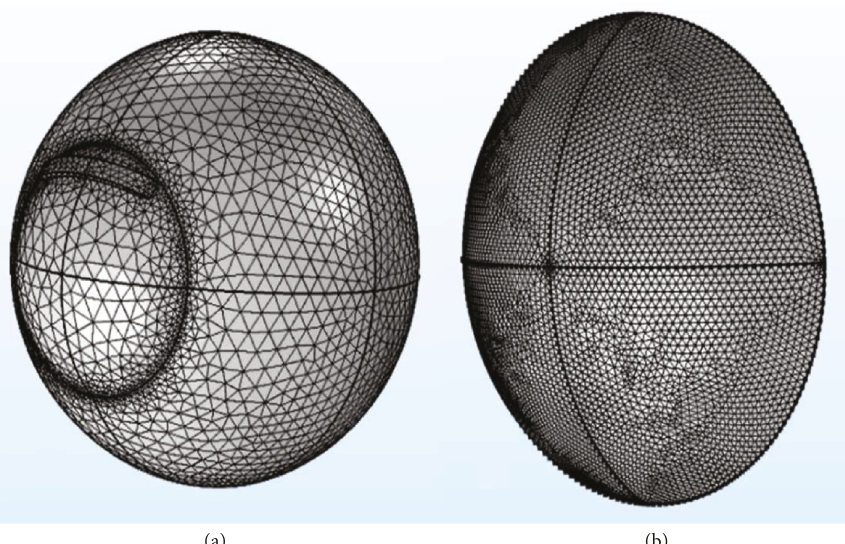
Figure 4: Meshing of the eye (a) and contact lens (b). The model was constructed using COMSOL Multiphysics v5.2 (https://www.comsol. com), and the collage of the exported images was made using Microsoft PowerPoint 2019 (https://www.microsoft.com/en-in/microsoft-365/